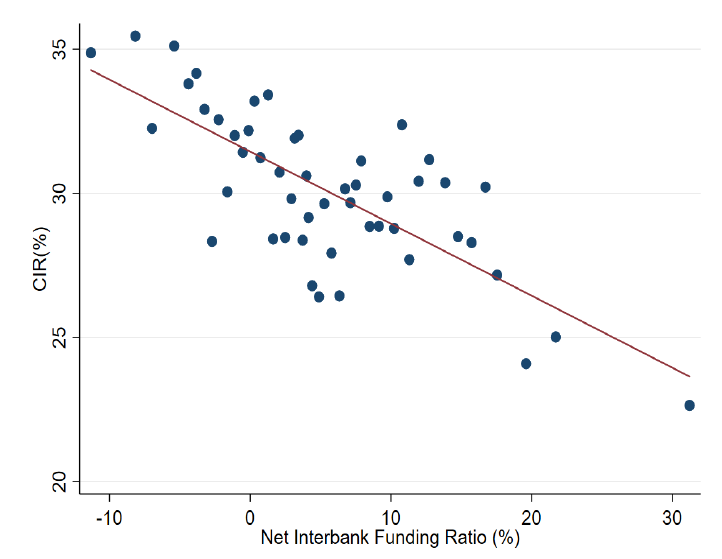
Figure 2. CIR and Net interbank funding Ratio. Notes: This figure depicts the relationship between CIR and net interbank funding ratio. The net interbank funding ratio is defined as the net interbank funding divided by the total liability. The interbank net interbank funding is calcuated as the interbank liabilities minus interbank assets. The interbank liability consists of overnight borrowing, PBOFI, and FA Repo. We deduct the interbank assets from the total liability to address the double counting issue. The sample includes 16 public listed banks. Data source: